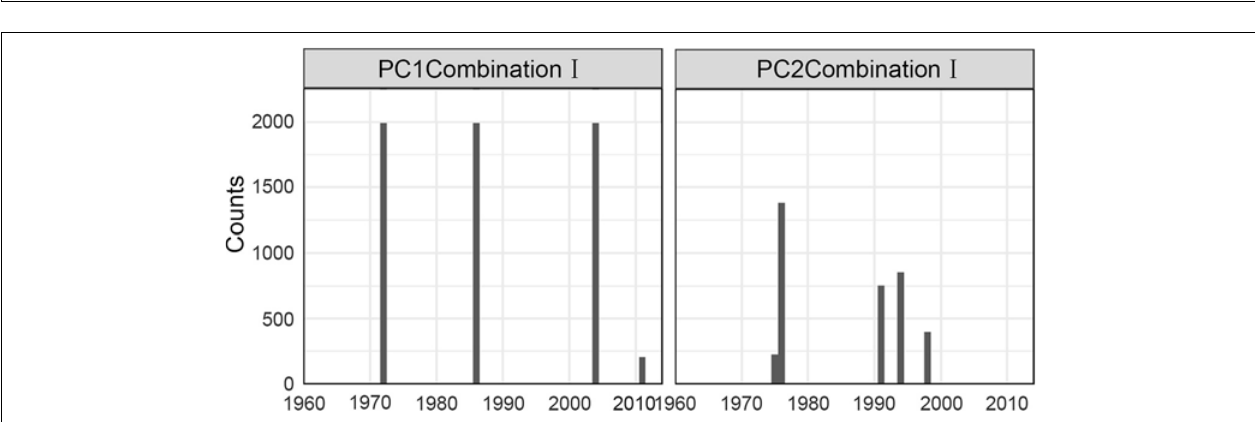
FIGURE 4 | PC scores for the final indicator suite (consist of ToC, LPC/ToC, MTL, MTC, T-J (cid:48) FD). Blue areas represent scores, green lines denote cumulative sums for scores and red lines represent regime means detected by STARTS.